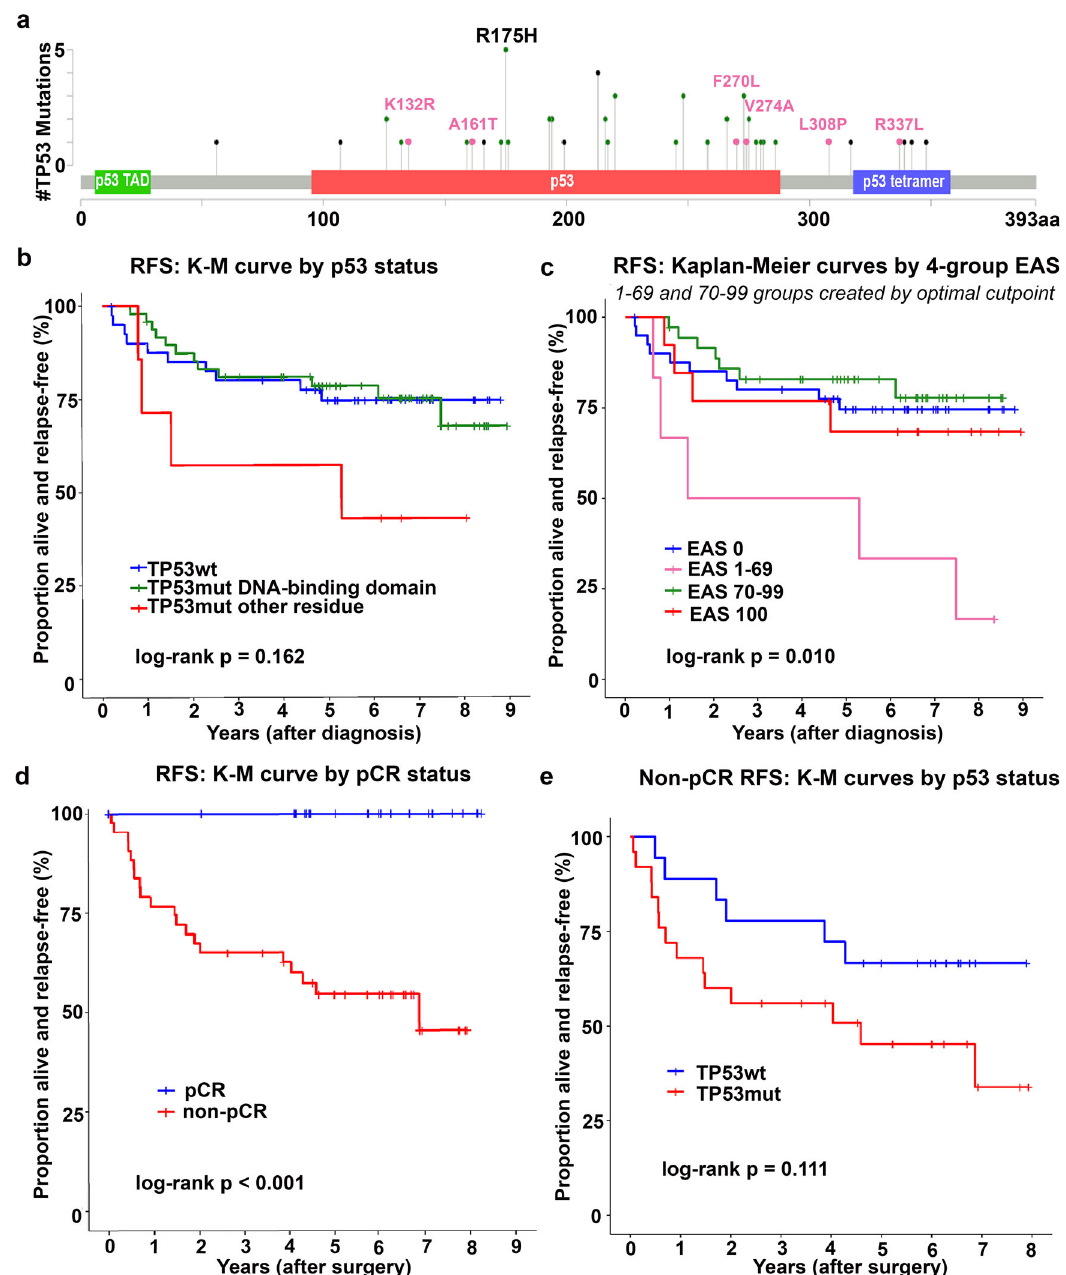
Fig. 1 Association of TP53 mutational status and clinical outcomes. a Lollipop plot showing location and sequence of TP53 mutations in study cohort. Pink mutations denote those comprising the EAp53 1-69 group. b RFS Kaplan – Meier curves by tumor TP53 mutation status and location (log-rank test p = 0.162). c Kaplan – Meier curves by EAp53 category. d RFS Kaplan – Meier curves by pCR status (log-rank test p < 0.001). e RFS Kaplan – Meier curves by tumor TP53 mutation status for 43 patients who did not achieve a pCR (log-rank test p =